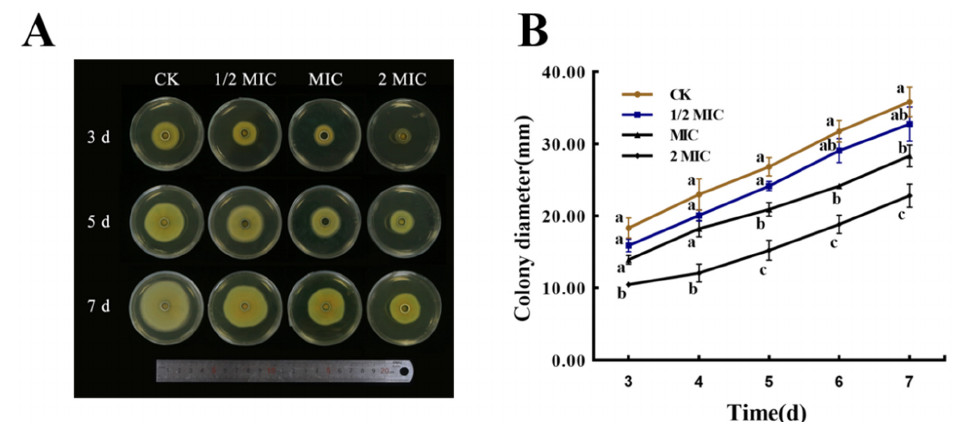
Figure 1. Effects of different concentrations of a PCT nanoemulsion on colony morphology and diameter of P. italicum. ( A ) Colony morphology at 3, 5, and 7 days. ( B ) Colony diameter from 3 to 7 days. Each value represents the mean ± SD. Means with different letters were significantly different at p < 0.05.